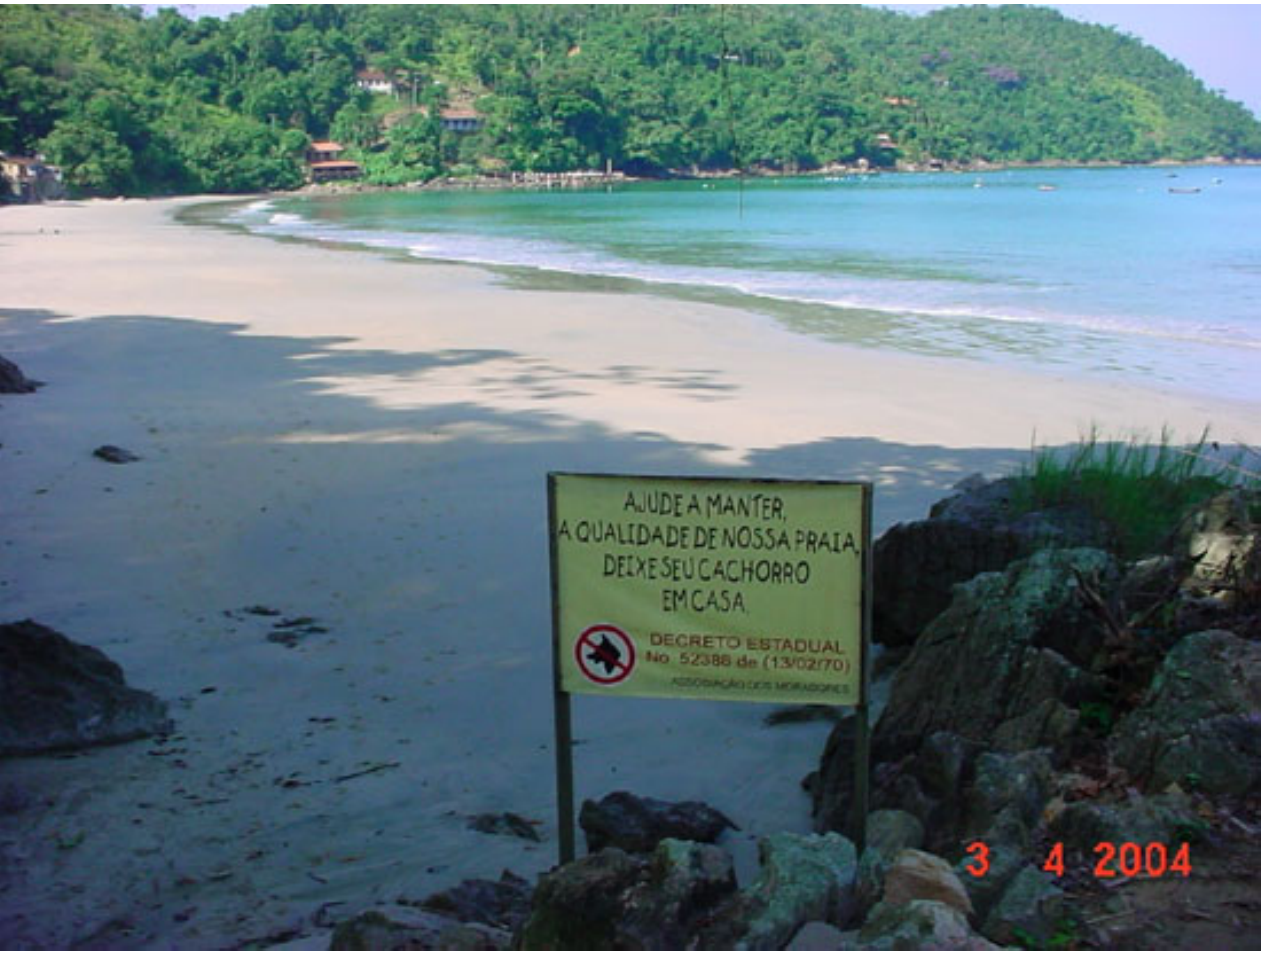
Fig. 8 . Almada Beach, located outside of the boundaries of the Serra do Mar State Park, São Paulo